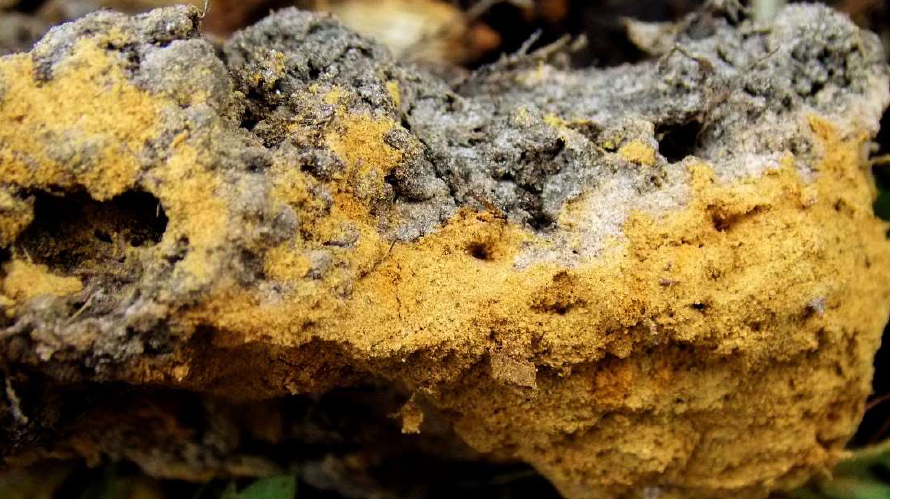
Figure 4. Soil after deconstruction of the pots. Dark soil at top is the A horizon, lighter patches below the A horizon are remnants of the E horizon, orange soil is the B horizon. Worm burrows are visible in both A and B horizons.